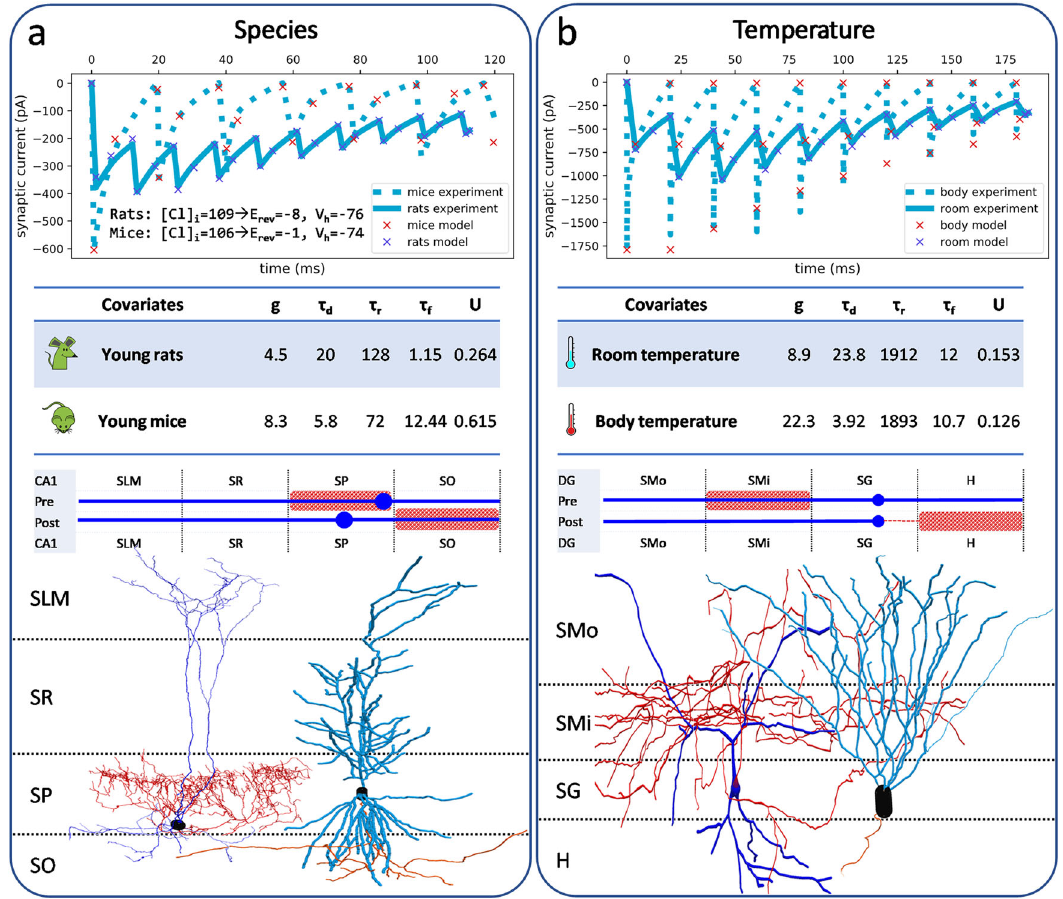
Fig. 1 Impact of covariates on synaptic properties. a Synaptic traces from two studies 67,68 recording GABAergic signals from CA1 Axo-axonic to CA1 Pyramidal cells in different species. Differences in intracellular solutions are also indicated. Note large differences in g, τ d, and U. Neuronal morphologies are from NeuroMorpho.Org 69 – 71 and displayed with schematics based on their axonal (red pattern) and soma-dendritic (blue dot and line) distributions across layers (SMo/SMi, outer/inner molecular; SG, granule; H, hilus; SLM, lacunosum-moleculare; SR, radiatum; SP, pyramidal; SO, oriens). b GABAergic signals from DG HICAP to DG Granule cells recorded at two different temperatures 72 . All other covariates were identical. Neuronal morphologies are from NeuroMorpho.Org 69,73,74